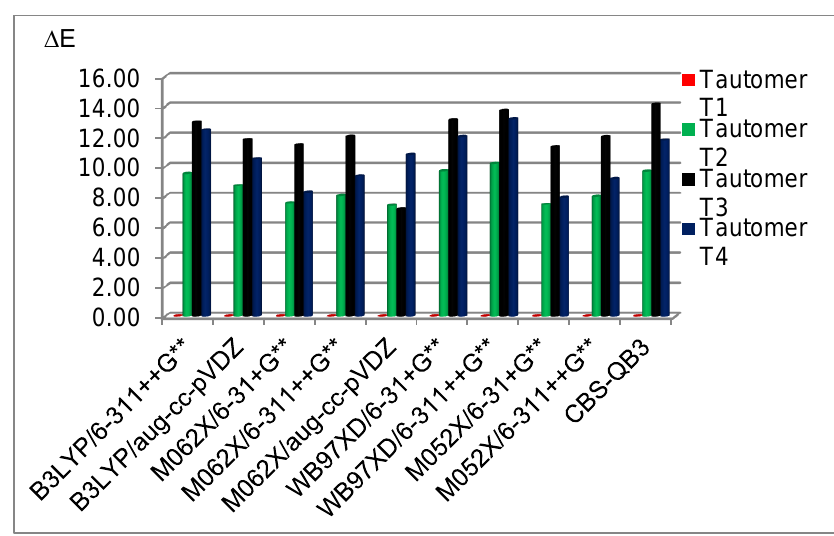
Figure 1. The relative energies of 5FU tautomers at different computational methods in the gas phase. Energies are referred to as the most stable tautomer T1. Table 1. Calculated relative energies for the T1–T4 tautomeric forms of 5FU ( G T , kcal/mol) in the gas phase and in water.